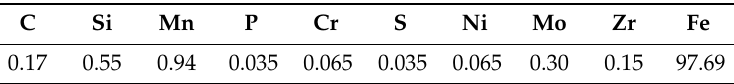
Table 1. Chemical composition of S355 steel (wt. %).